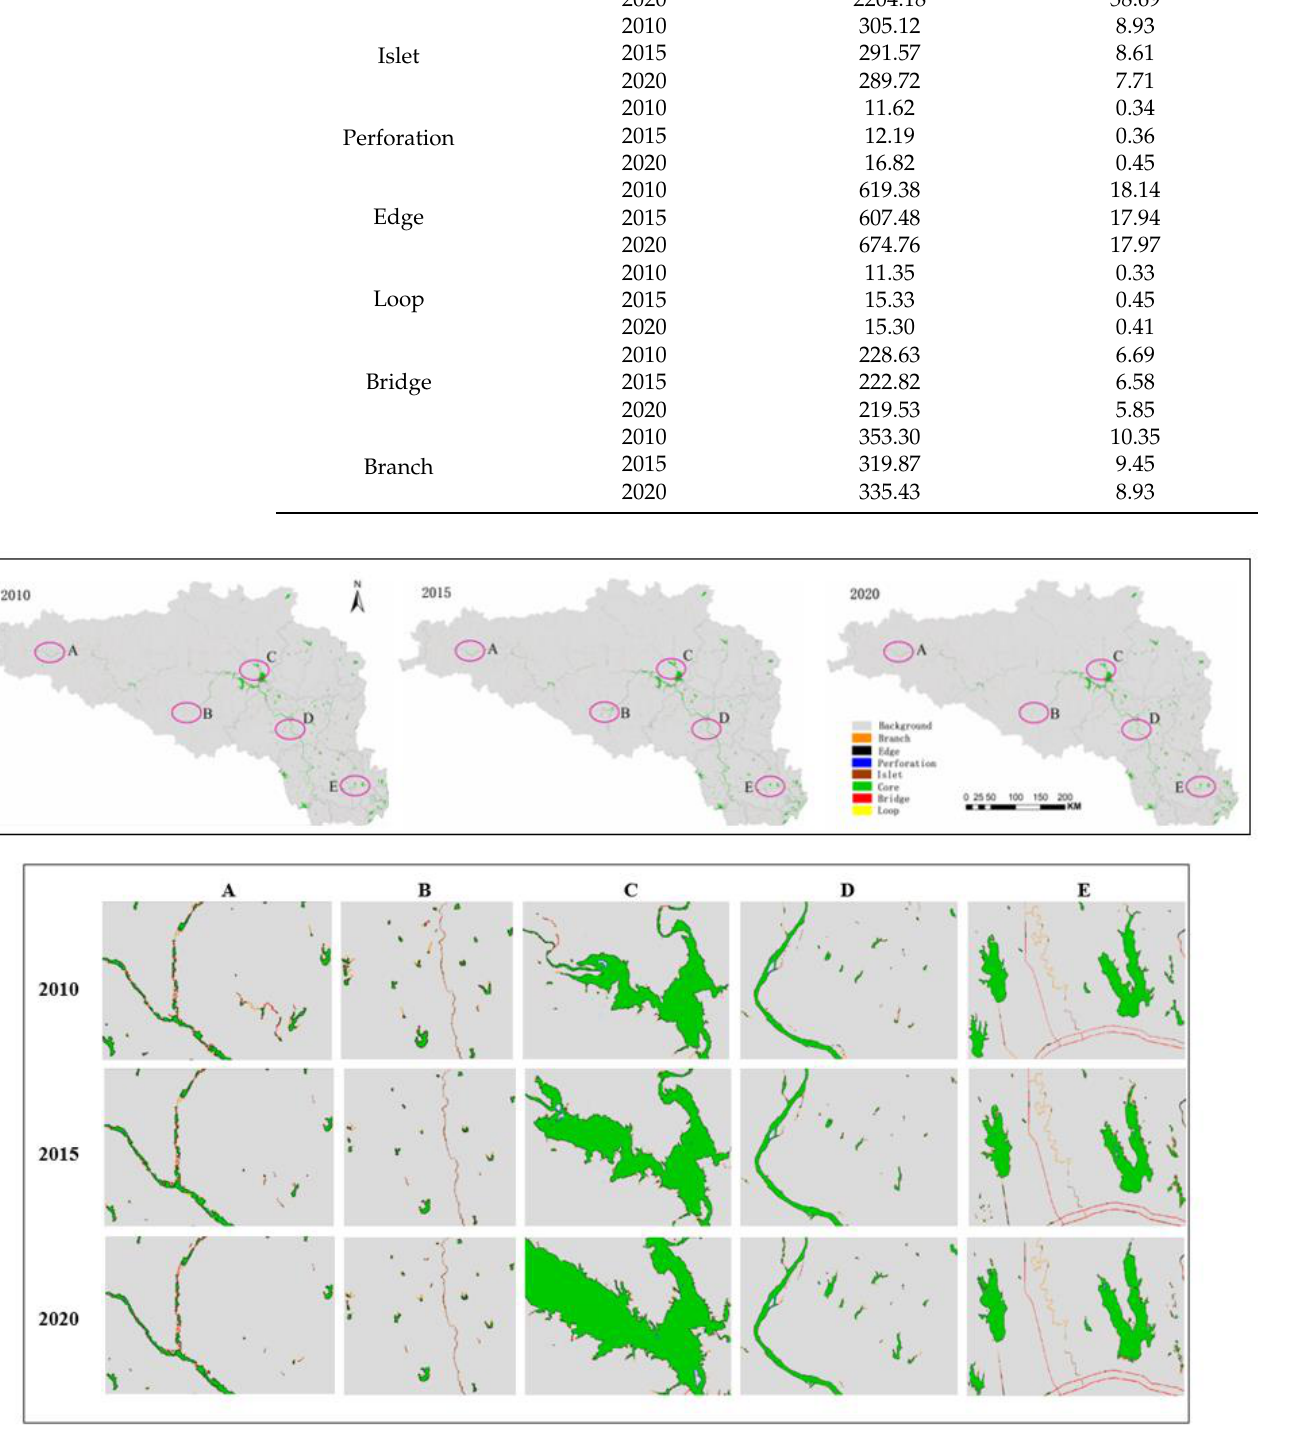
Figure 2. Spatial variation based on MSPA in the study area in 2010, 2015, and 2020; ( A , B ) — the Hanjiang River ’ s upper reaches; ( C ) — the Danjiangkou Reservoir; ( D , E ) — the Hanjiang River ’ s middle and lower reaches).